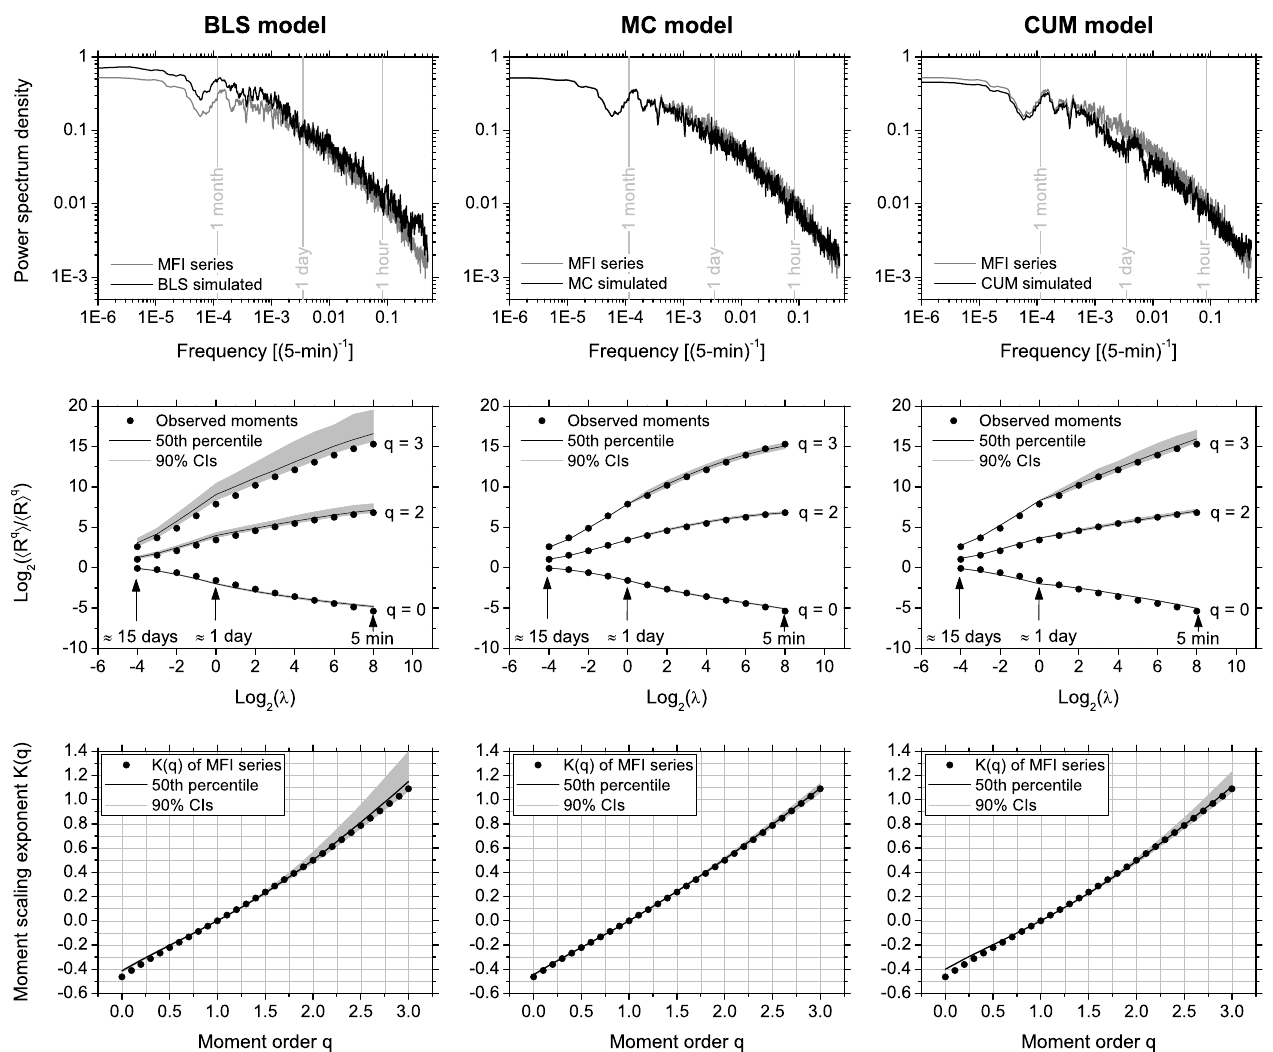
Fig. 6. Top panels show the PSD of three representative rainfall series simulated by BLS, MC, and CUM models (black lines) along with the PSD of the observed MFI series (grey lines). Middle panels show the traces of normalized moments of the observed MFI series (points) and the median patterns corresponding to the sequences simulated by the three models (lines). Grey areas denote the 90% confidence intervals (CIs) computed on 100 simulations. Bottom panels illustrate the K(q) functions corresponding to the trace moments shown in the middle panels.